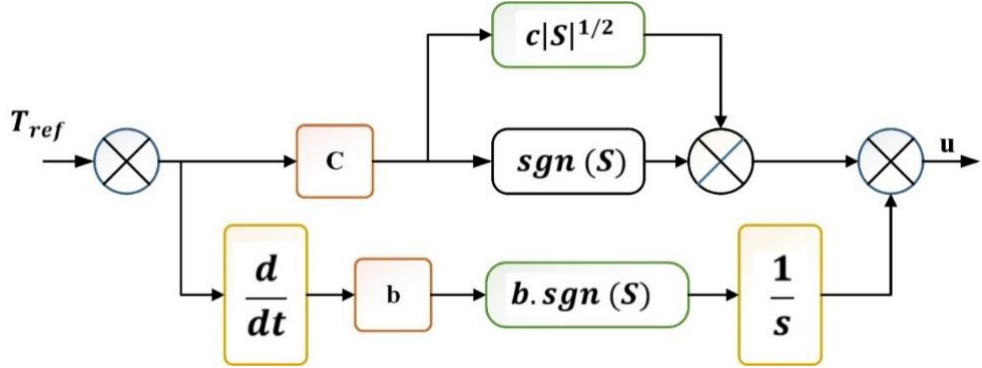
Figure 4. Block diagram of ST-SMC [43].